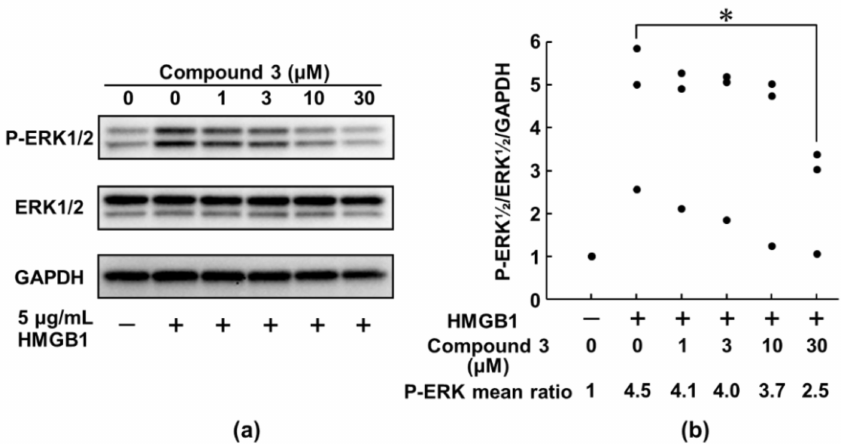
Figure 4. Suppressive effect of compound 3 on the HMGB1-induced activation of ERK 1/2. RAW264.7 cells were pretreated with compound 3 at the indicated concentrations for 2 h and then stimulated with HMGB1 (5 µ g/mL) for 18 h. Cell lysates were subjected to Western blotting using phospho- ERK 1/2 (P-ERK 1/2) and total ERK 1/2 antibodies as described in the Materials and Methods section. GAPDH served as a loading control. The panels depicted a typical immunoblot ( a ) and values presented as mean ratio of three independent experiments of each P-ERK 1/2, ERK 1/2, and GAPDH band intensities were calculated by densitometric analysis ( b ). * p < 0.05 was accepted as a significant